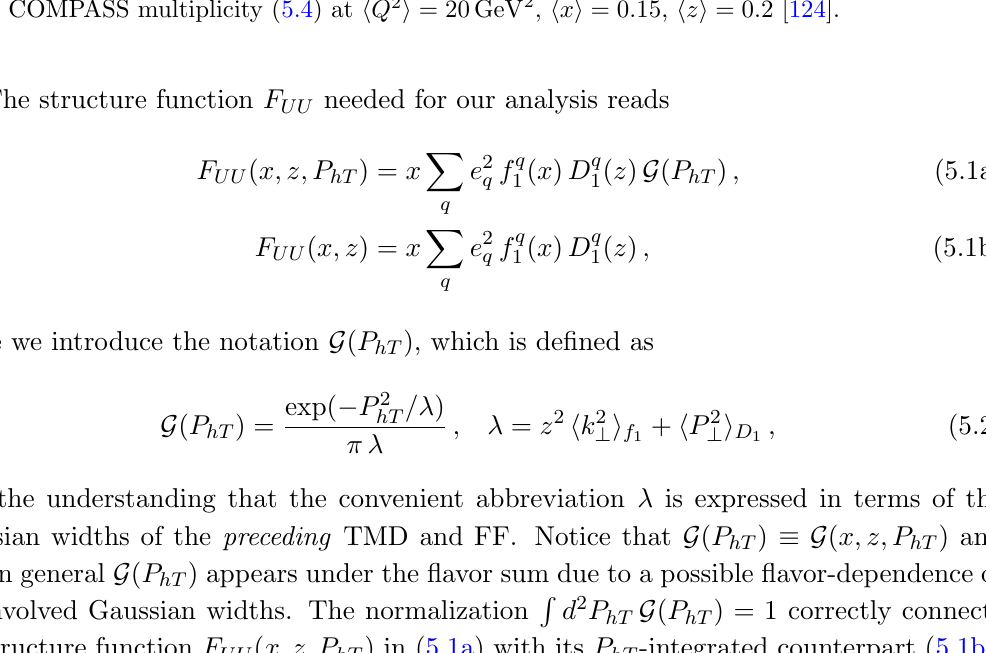
Figure 4. Left panel: F UU ( P 2 ) =F UU (0) for (cid:25) + production at JLab with a 5.75 GeV e (cid:0) beam [122]. hT Middle panel: HERMES multiplicity (5.3) at h Q 2 i = 2 : 87 GeV 2 , h x i = 0 : 15, h z i = 0 : 22 [123]. Right panel: COMPASS multiplicity (5.4) at h Q 2 i = 20 GeV 2 , h x i = 0 : 15, h z i = 0 : 2